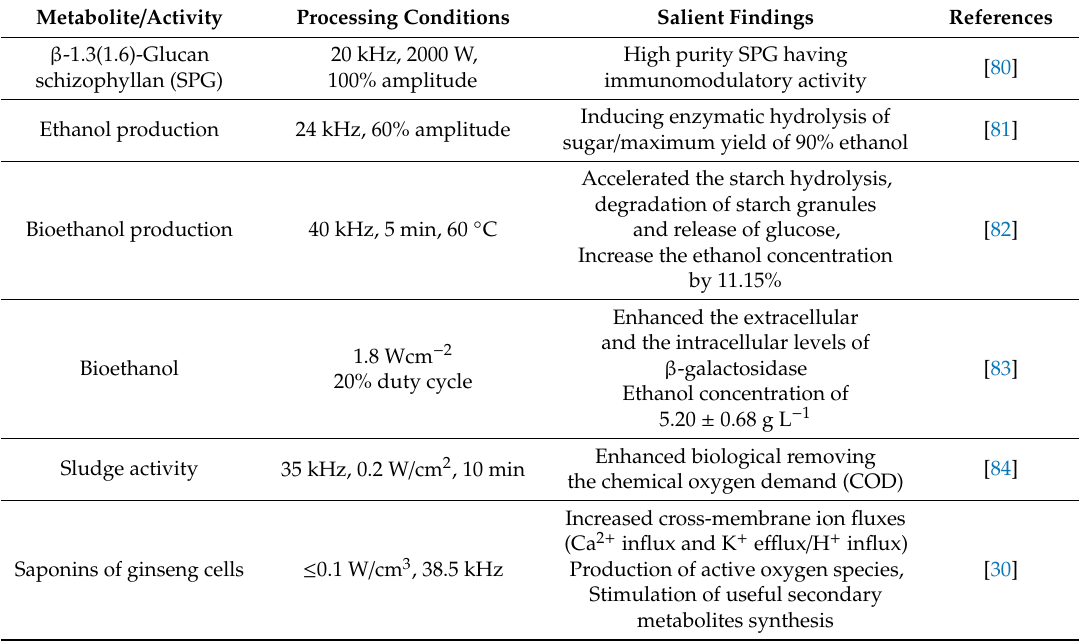
Table 2. Application of ultrasound technology for the production or activation of various microbial metabolites and